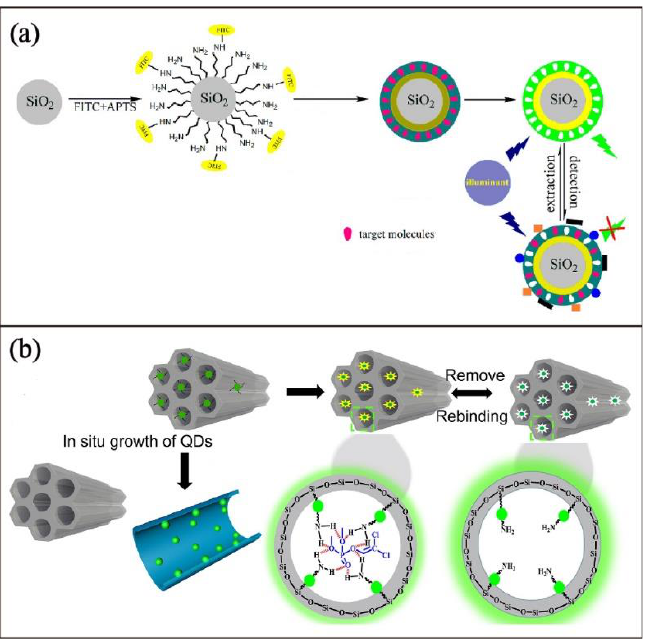
Figure 6. Schematic illustration of ( a ) preparation of fluorescent core-shell MIP sensor for λ -cyhalothrin. Adapted with permission [72]. Copyright 2015, American Chemical Society. ( b ) Fabrication of perovskite QDs in the mesopores of imprinted silica polymer for 2,2-dichlorovinyl dimethyl phosphate detection. Adapted with permission [75]. Copyright 2020, Elsevier.